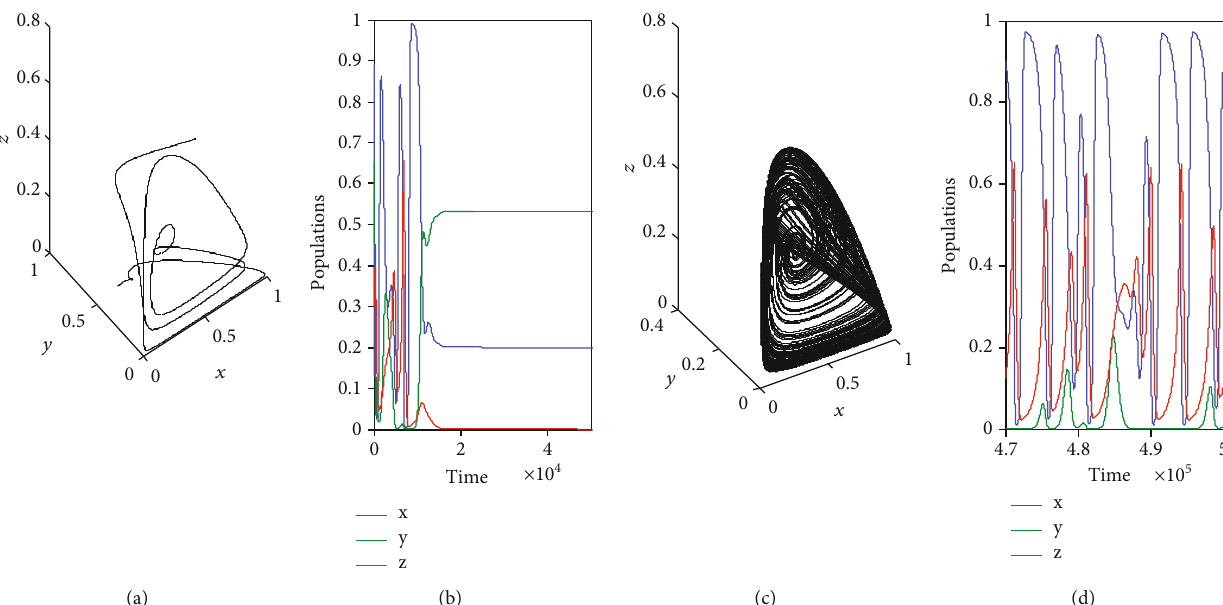
= ð 0 : 2, 2 = 0 : 19 . (d) Time series of attractor in (c). + where w 2